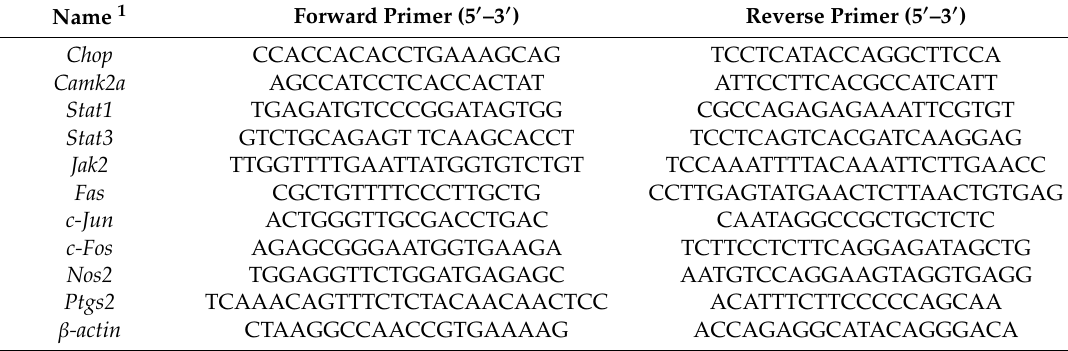
Table 1. Primers used for quantitative